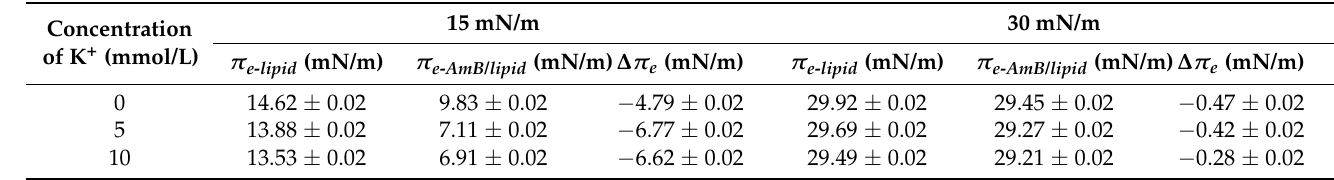
Table 1. The equilibrium values ( π e ) of the surface pressure for the DPPC/Chol mixed monolayer ( π e - lipid ) and the DPPC/Chol/AmB monolayer ( π e - AmB / lipid ) at 15 mN/m and 30 mN/m.